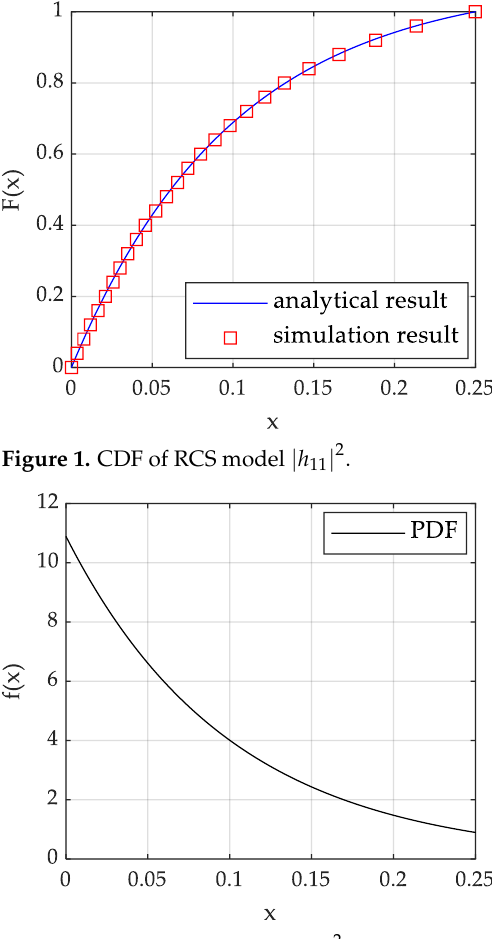
Figure 2. PDF of RCS model | h 11 | 2